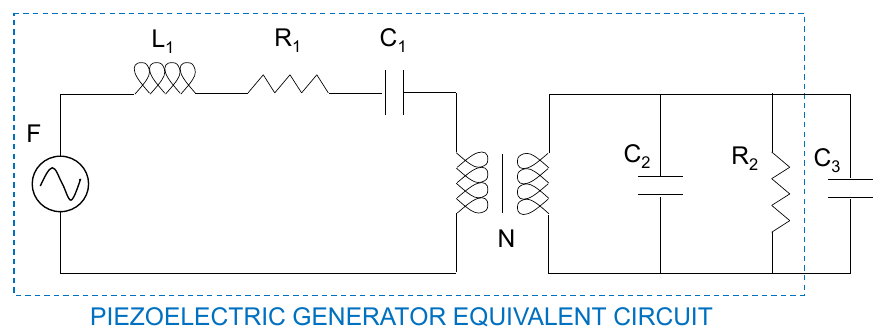
Figure 3. Piezoelectric generator equivalent circuit used to obtain the output voltage in a resistive load situation.